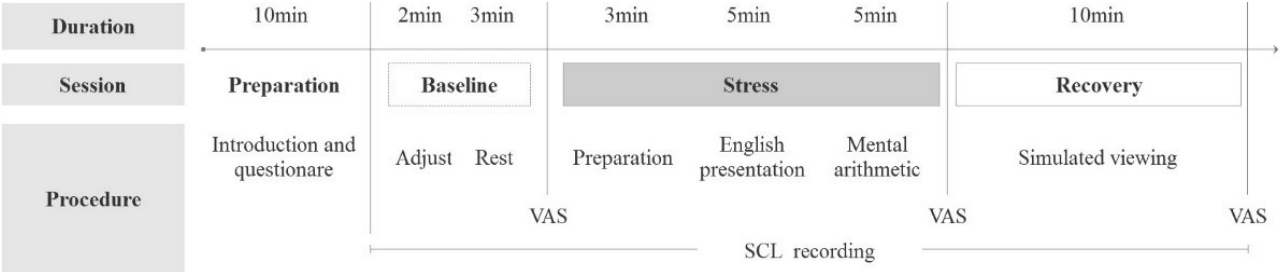
Figure 2. Experimental